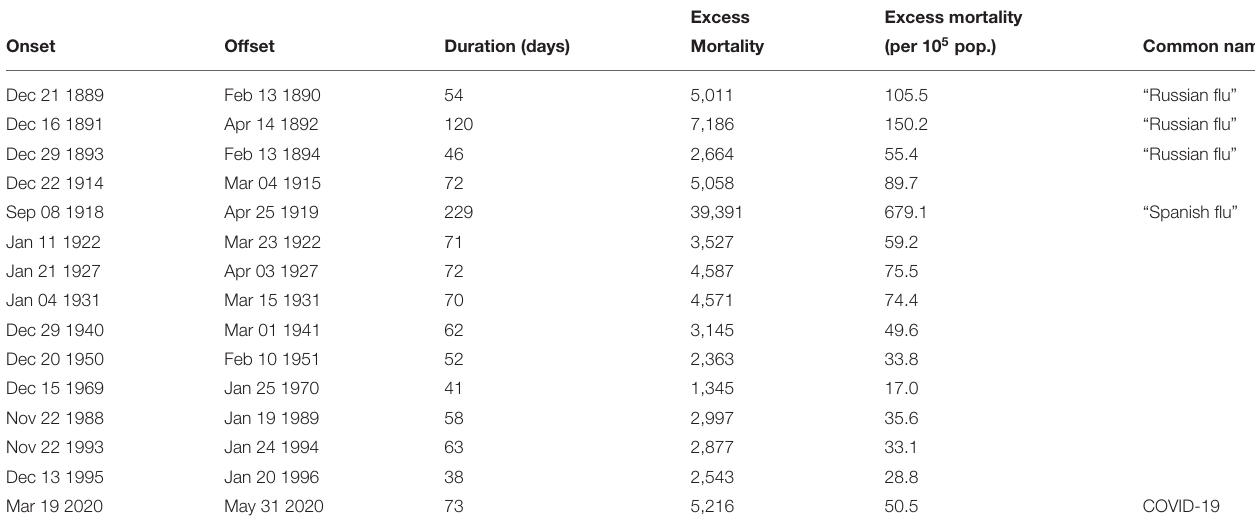
Excess Excess mortality